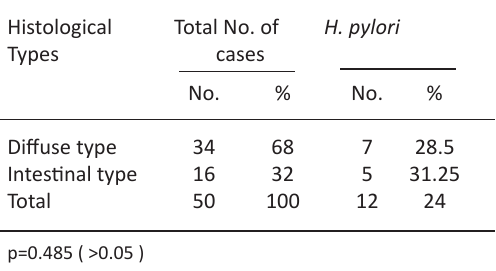
Table 4. Incidence of H. Pylori according to site of Growth